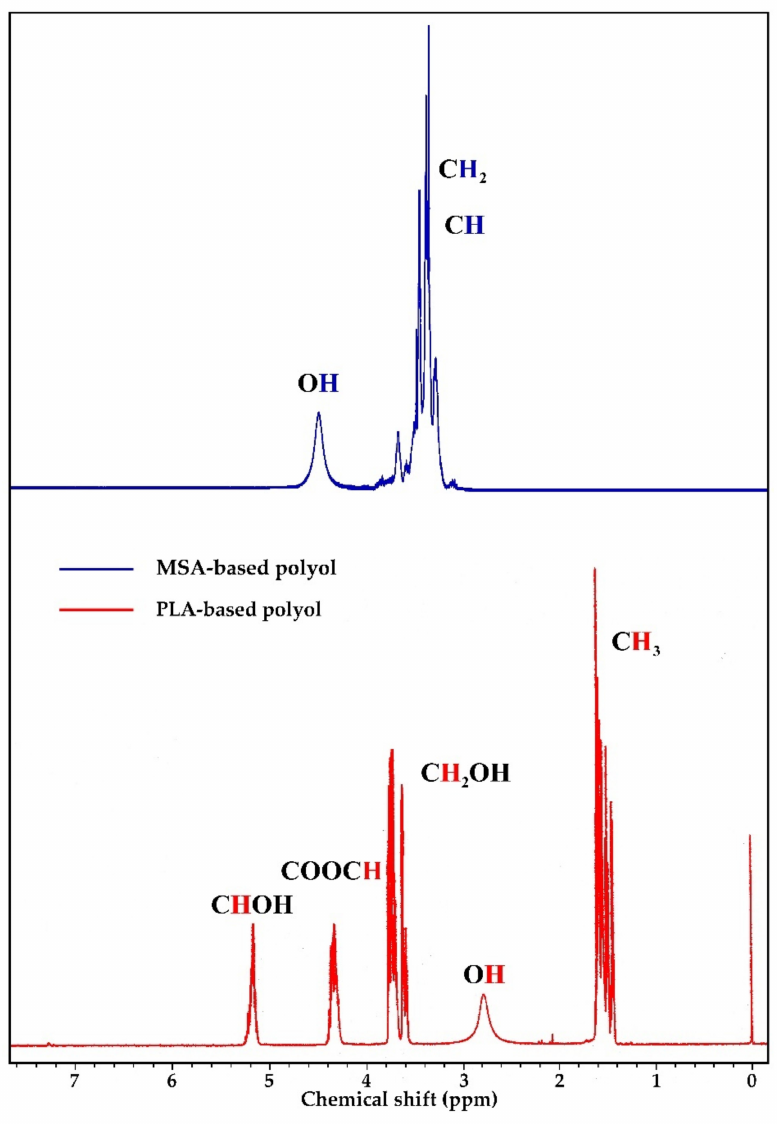
Figure 2. 1 H NMR spectra of MSA- and PLA-based